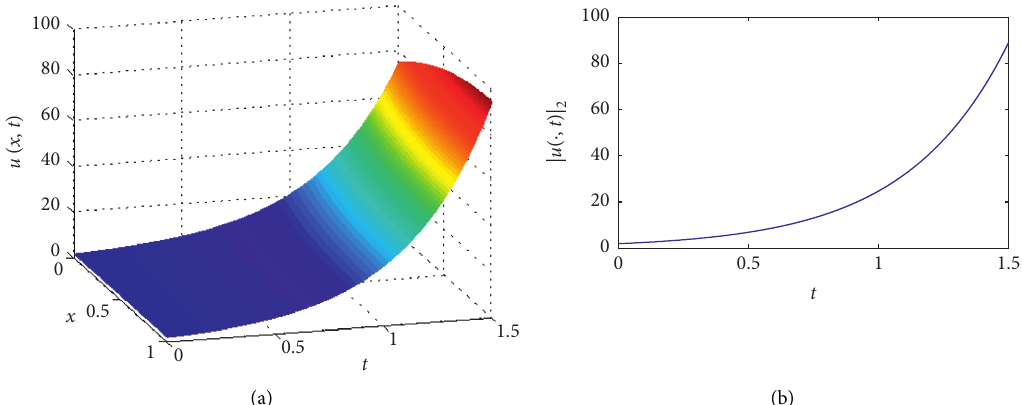
Figure 1: Simulation results for the open-loop linear parabolic DPS (1)–(3). (a) Open-loop profile of evolution of u ( z,t ) . (b) Open-loop trajectory of | u (· , t )| . 2